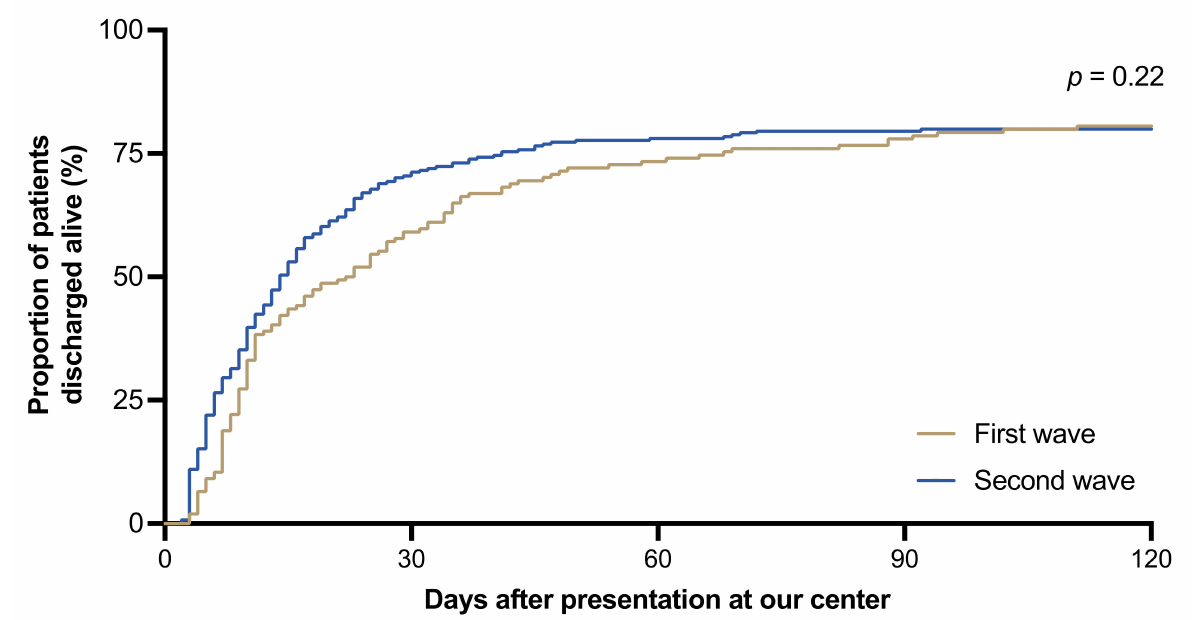
Figure 3. The proportion of patients discharged alive during the first and second waves compared by the log-rank